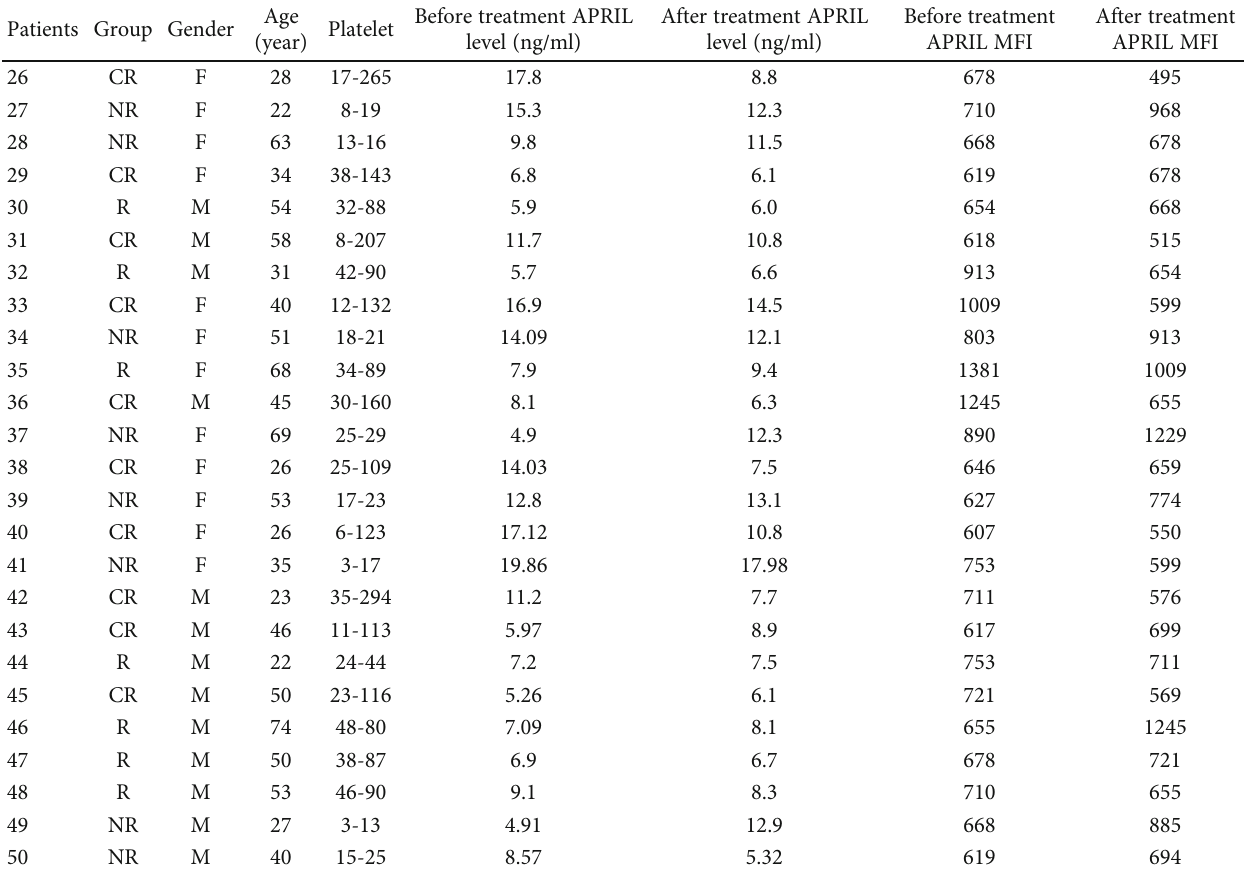
Table 2: Basic characteristics of chronic ITP patients.